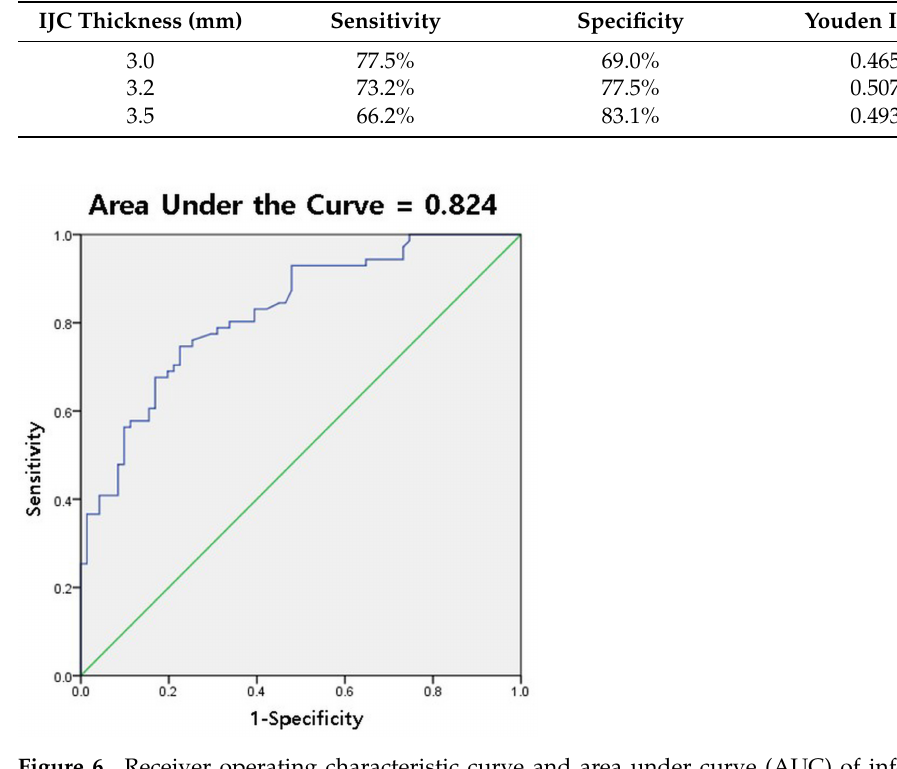
Figure 6. Receiver operating characteristic curve and area under curve (AUC) of inferior joint capsule thickness on ultrasonography in the neutral position for the diagnosis of frozen shoulder (AUC =